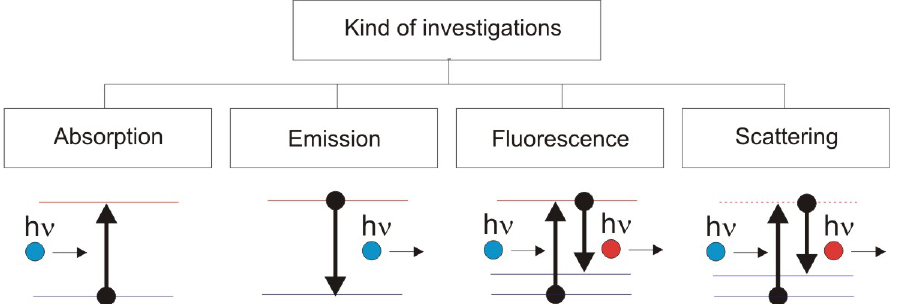
Figure 4. Measurement methods based on characteristic photon interaction and spectra of